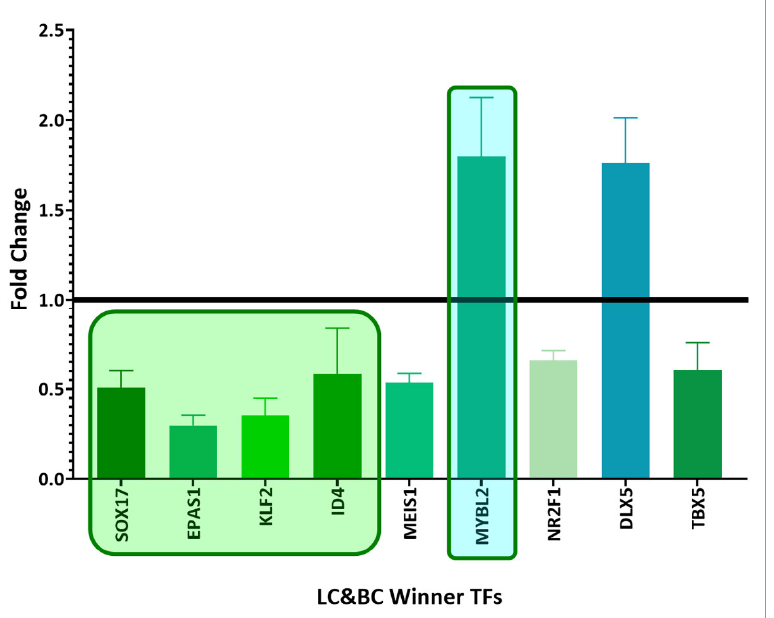
Figure 3. Bar graph comparing the fold change expression levels of common winning transcription factors in lung cancer and breast cancer (LC&BC). Transcription factors with fold change values greater than 1 are upregulated, while those with fold change values less than 1 are downregulated. Inside the boxes are the deregulated transcription factors in most datasets and those that are coexpressed in gene networks. The image was made using GraphPad Prism version 8.00 for Windows, GraphPad Software, La Jolla, California, USA, www.graphpad.com (accessed on 23 June 2022) .